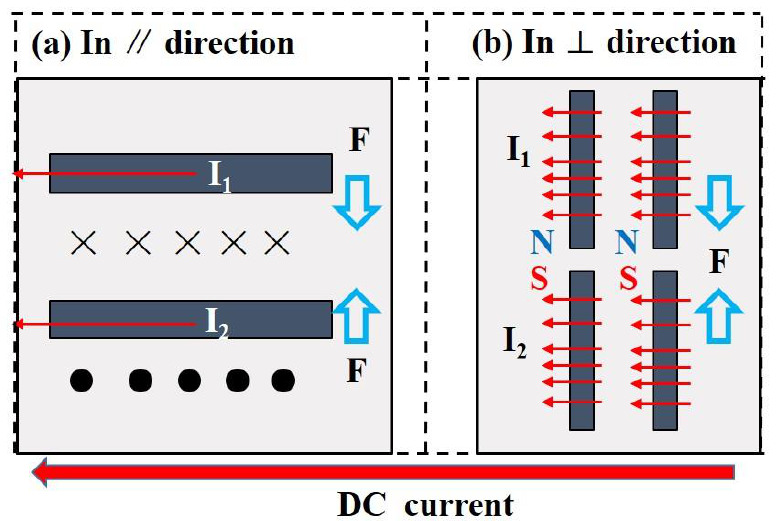
Figure 3. Schematic diagrams of the interaction between carbon fibers under the DC current. ( a ) In ∥ direction. ( b ) In ⊥ direction. Black rectangles denote carbon fibers.